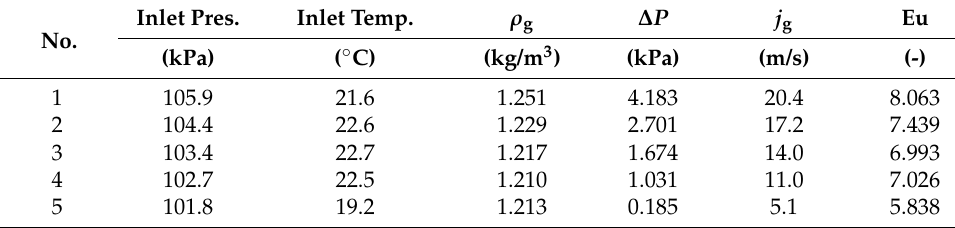
Table 4. Single-phase test results for half-scale test section.